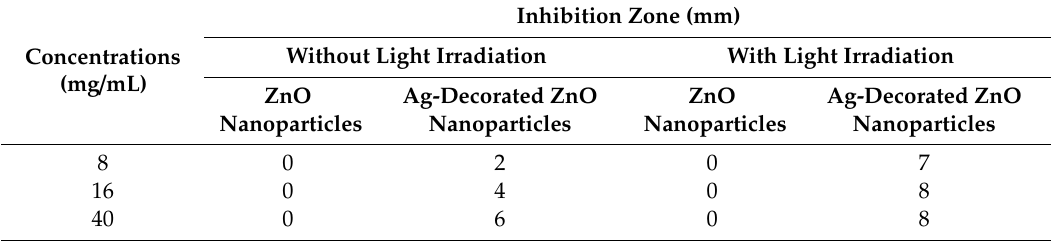
Table 4. Antibacterial activity against E. coli bacteria of ZnO nanoparticles and Ag-loaded ZnO nanoparticles.